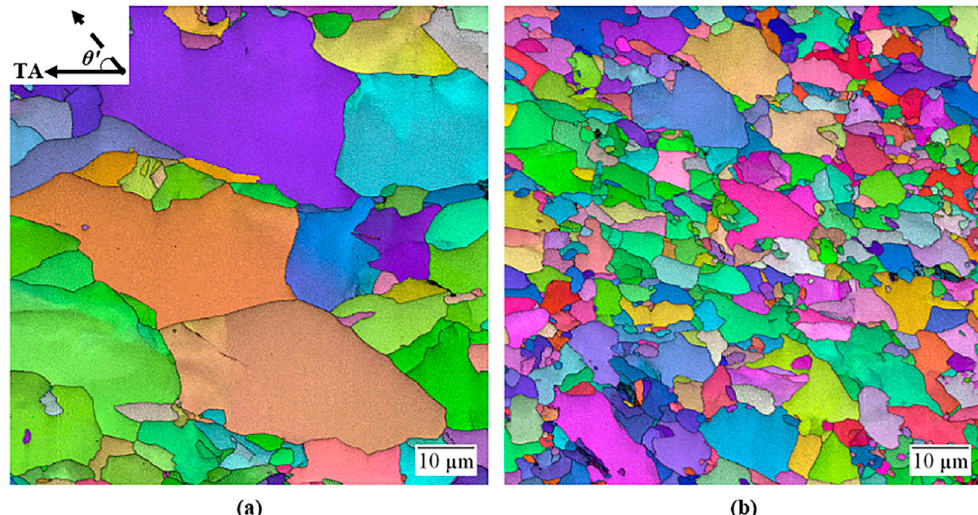
Figure 15. Composite image quality and inverse pole figure maps obtained with EBSD analysis of the polygonal ferrite microstructures produced via ( a ) High T Finish and ( b ) Low T Finish simulations followed by isothermal holding at 650 °C for 30 min. The 0.724 radial position is shown in both. The torsional axis (TA) is horizontal to the page.